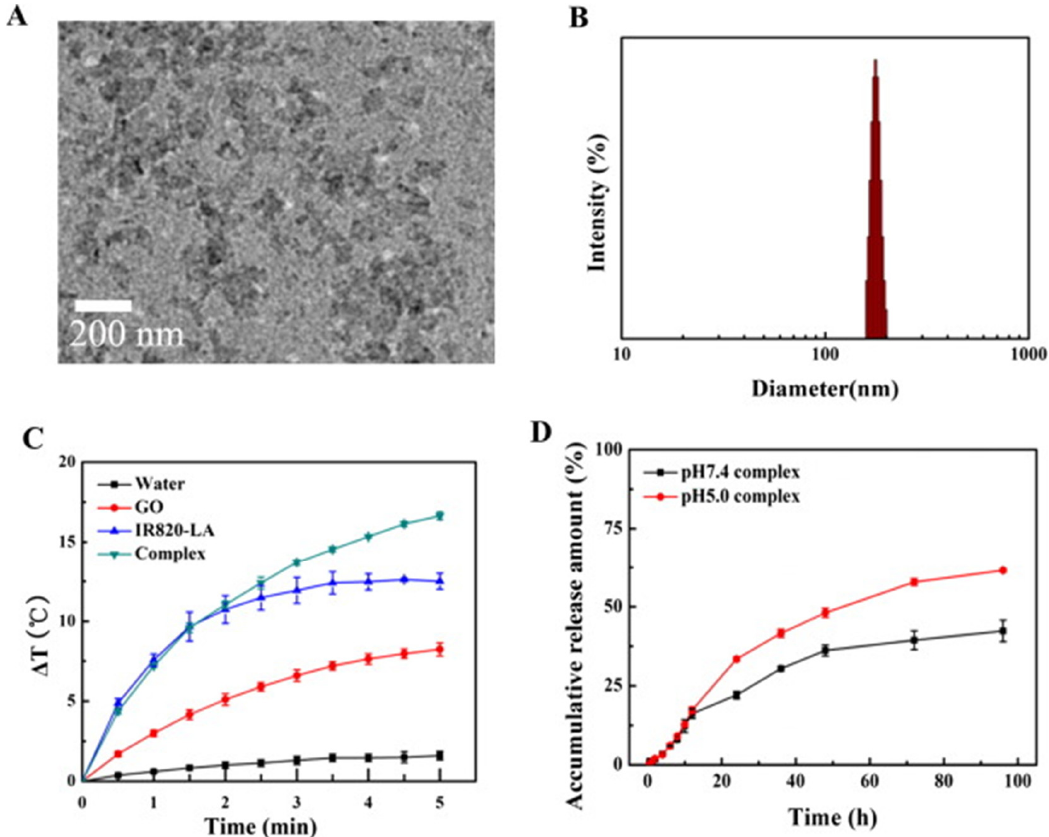
Figure 4. ( A ) TEM image of the composite; ( B ) Composite particle size distribution (DLS); ( C ) Photothermal effect curves of the composite, IR820-LA, GO, and water under a 660 nm laser (n = 3); and ( D ) In vitro DOX drug release of the compo- site. Complex* correspond to GO/DOX/IR820-LA composite. Reproduced from Ref. [67] with permission from